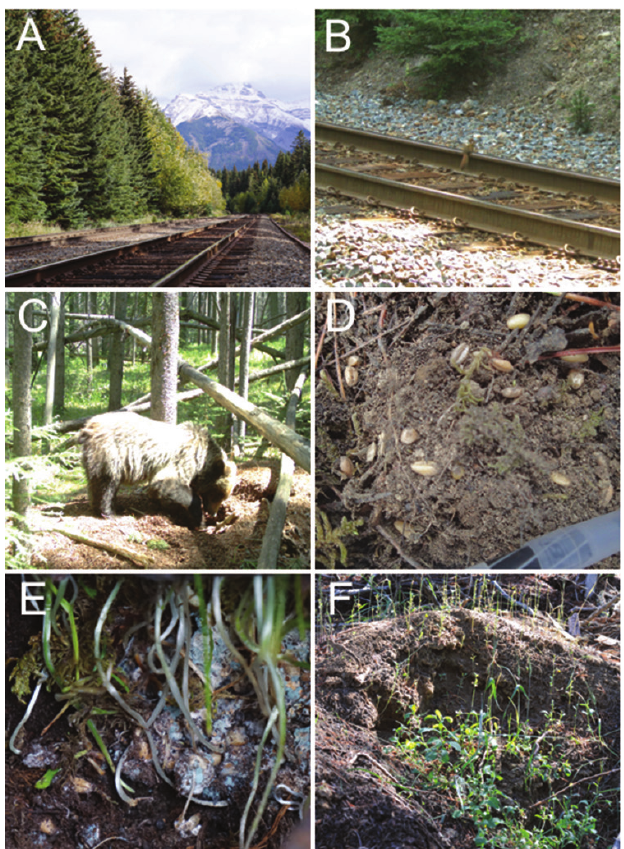
Figure 1. Evidence of bears interacting with squirrel middens for access to agricultural seeds. A Railway in Banff National Park, where agricultural seeds are found on the tracks. B American red squirrel on the rail- way, taken with a remote camera on time-lapse settings C Grizzly bear excavating a squirrel midden where bear signs were previously recorded during a survey of an area with high bear use. The photo was taken with a remote camera on hyperfire settings D Unsprouted agricultural seeds, visibly wheat and lentil, found at an active midden near the railway that had been recently excavated E Moldy sprouted and unsprouted agricultural seeds, visibly chickpeas, wheat, flax, lentils and canola, at an excavated inactive primary midden near the railway F Sprouted agricultural plants at an inactive primary midden near the